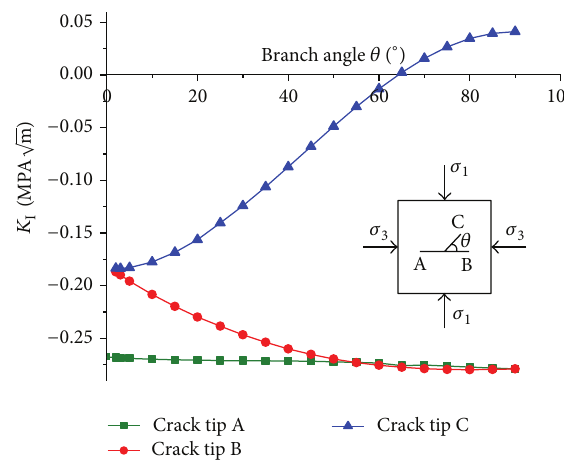
Figure 6: Curves of SIF 𝐾